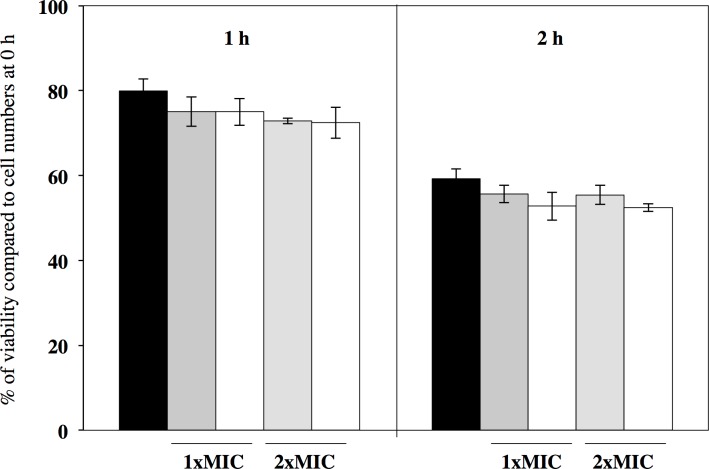
Effect of GRA and GRA derivatives on S. aureus cell viability under non-growing conditions.Cell viability was evaluated under non-growing conditions following the addition of GRA or GR-SU. The methods are described in the Materials and Methods section. S. aureus MW2 was treated with 1x MIC and 2x MIC of GR-SU (grey bar) or GRA (white bar) in 10 mM sodium phosphate buffer. An untreated bacterial culture (black bar) was used as a control. After 1 and 2 h of incubation, the reaction mixtures (100 μl) were plated on trypticase soy agar and incubated at 37°C overnight. The colony forming units (CFUs) were determined as the total number of colonies identified on each plate. The antibacterial effect was calculated as the ratio of the number of surviving cells (survival rate %) to the total number of bacteria incubated. Three independent experiments were performed, and the mean ± SD was calculated. The data were analyzed for statistically significant differences compared to the untreated control by a two-way ANOVA followed by Dunnett’s post hoc test. Significant differences were not observed.